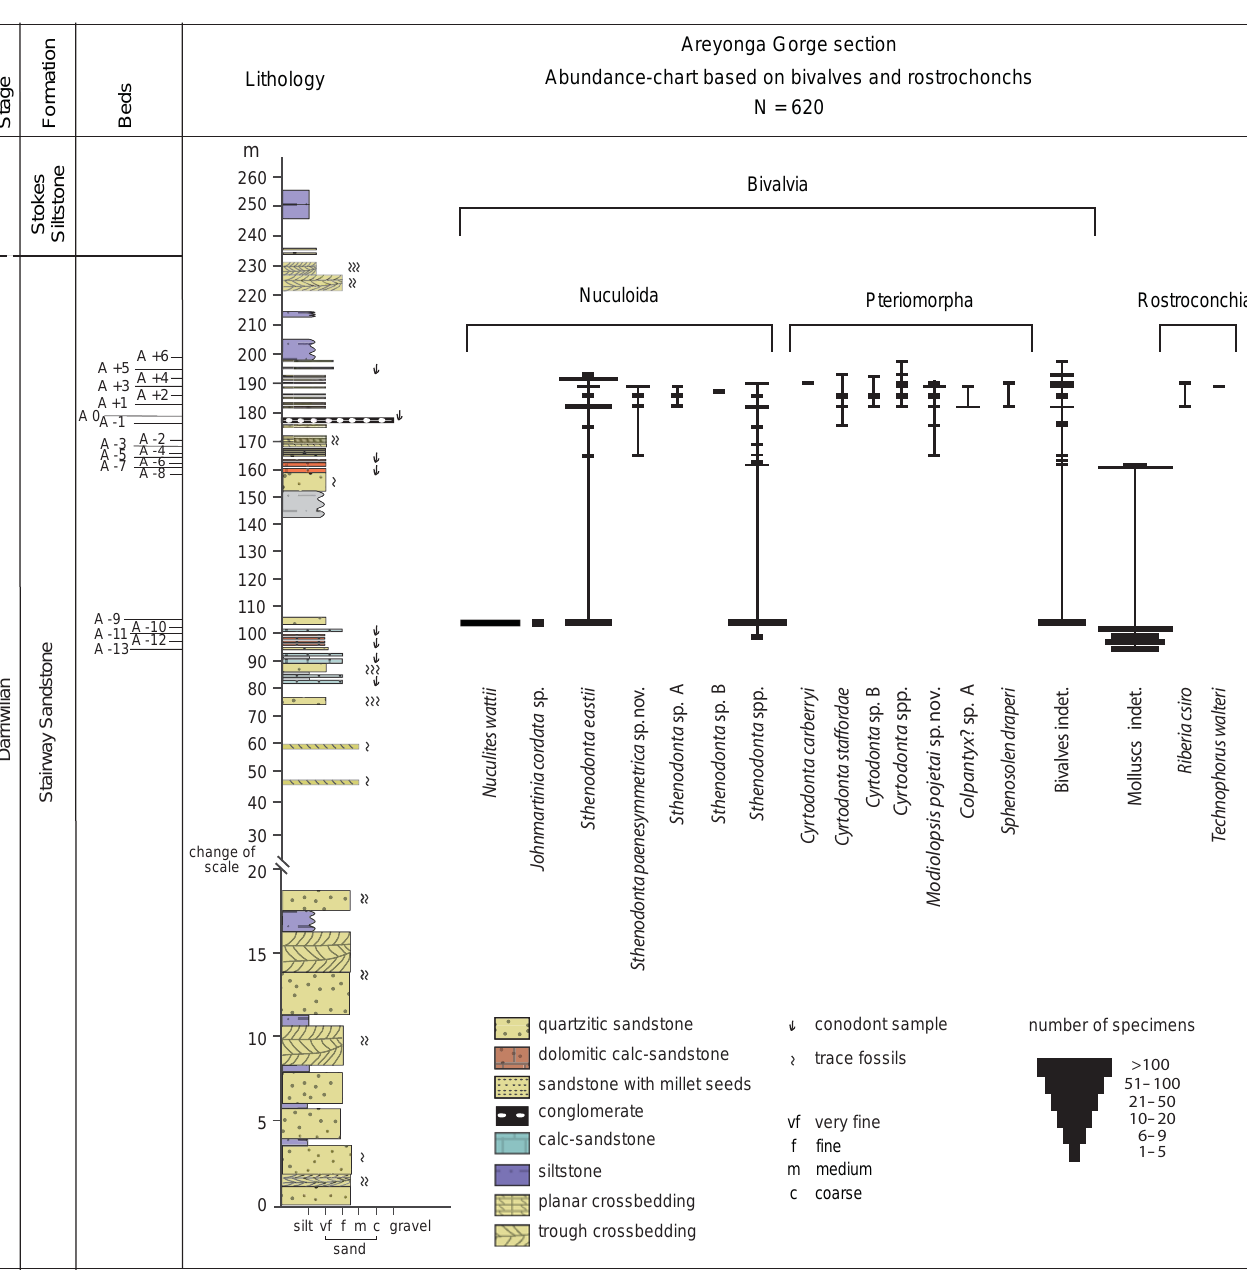
Fig. 4. Composite log of the Stairway Sandstone and abundance-charts showing distribution of bivalves and rostroconchs in the Areyonga Gorge